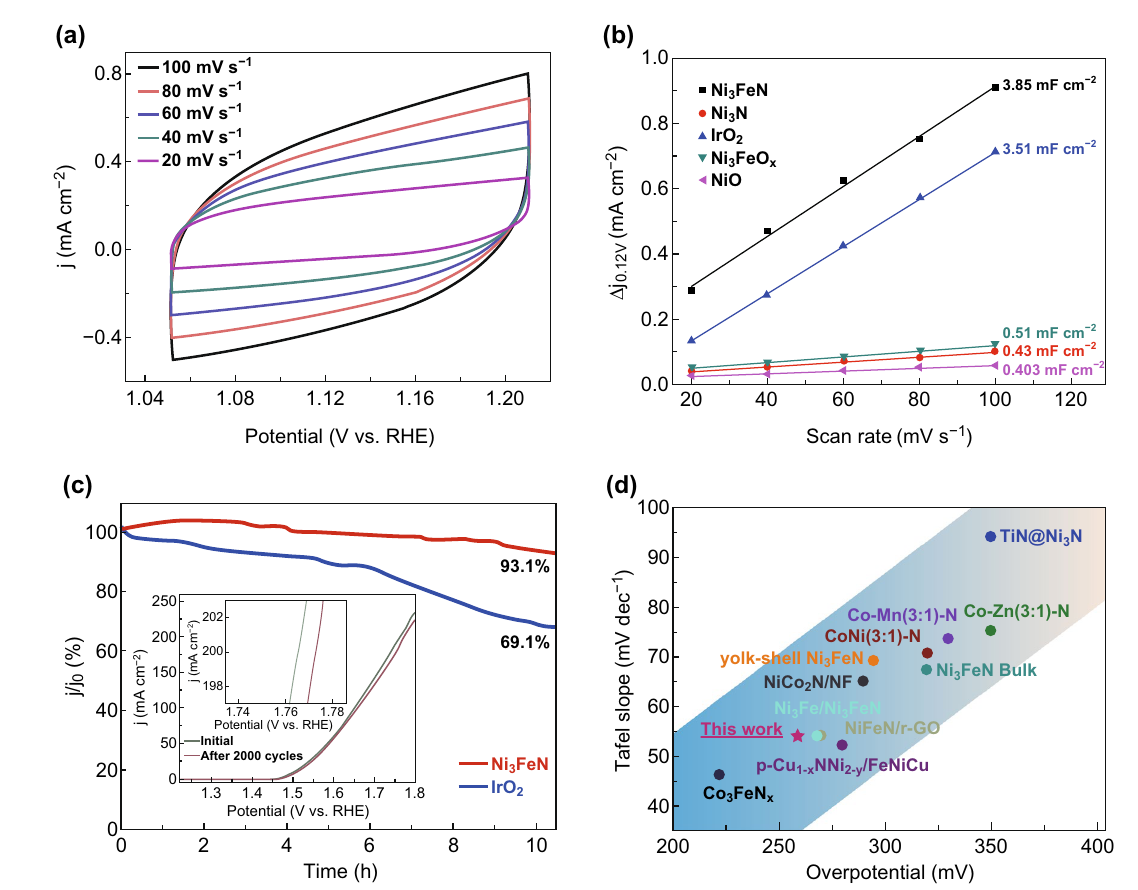
Fig. 5 a Cyclic voltammograms for Ni 3 FeN with a scan rate of 20, 40, 60, 80, and 100 mV s −1 in 1 M KOH. b The capacitive current density at 0.12 V as a function of the scan rate for NiO, Ni 3 N, IrO 2 , Ni 3 FeO x and Ni 3 FeN electrocatalysts. c Chronopotentiometry of Ni 3 FeN and IrO 2 at an overpotential of 370 mV (inset shows polarization curves recorded for the catalysts before and after 2000 cycles of CV scans. d Comparison of the electrocatalytic performance (Tafel slopes and the overpotentials reaching a current density of 10 mA cm −2 ) of mesoporous Ni 3 FeN with other nitrides reported